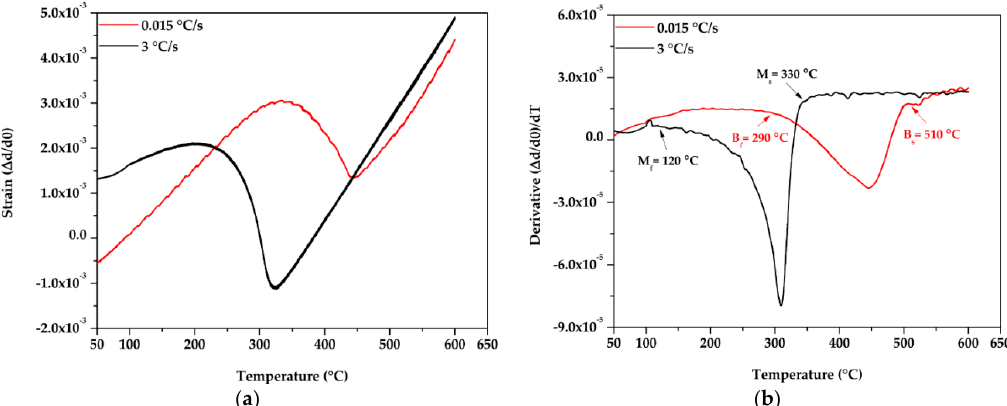
Figure 14. Thermal expansion versus temperature for different cooling rates. Samples were cooled from 900 °C to room temperature at the rates of 0.015 and 3 °C/s: ( a ) Strain ( ∆ d/d 0 ); ( b ) First derivative of the thermal expansion.